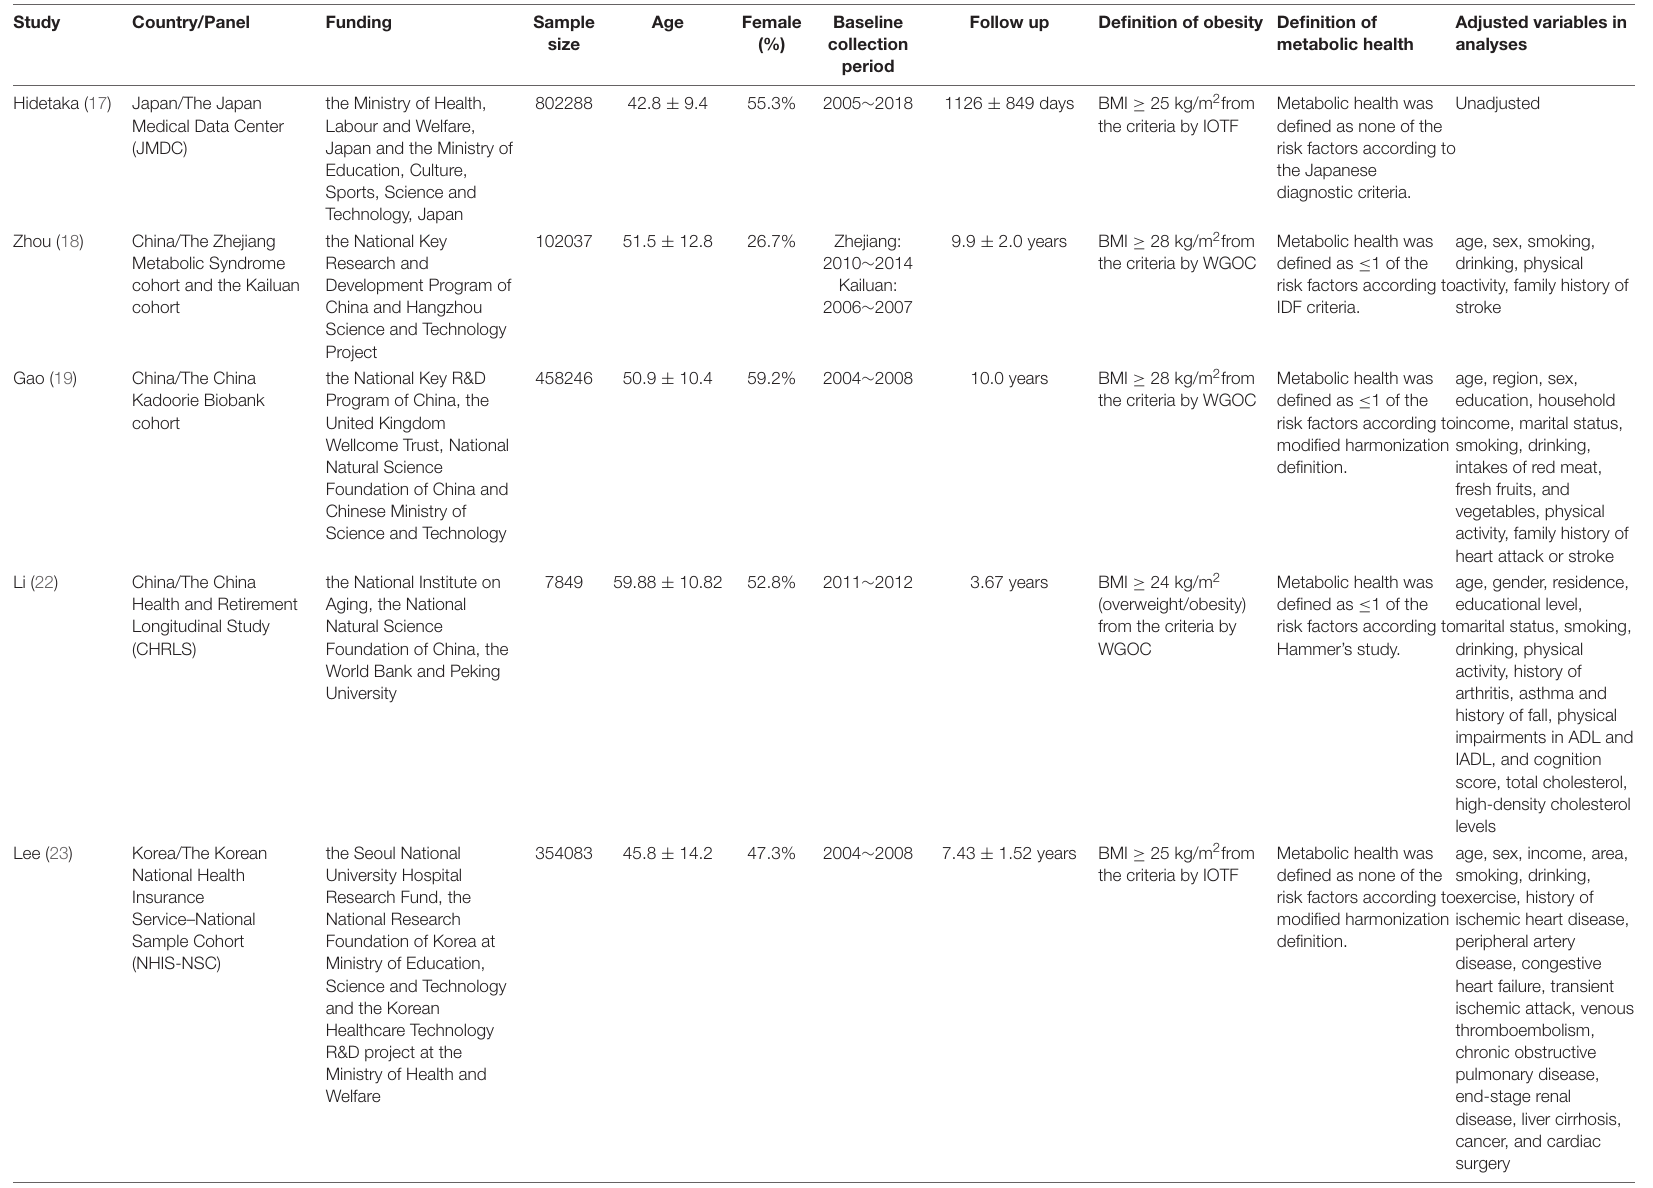
TABLE 1 | Characteristics of the included